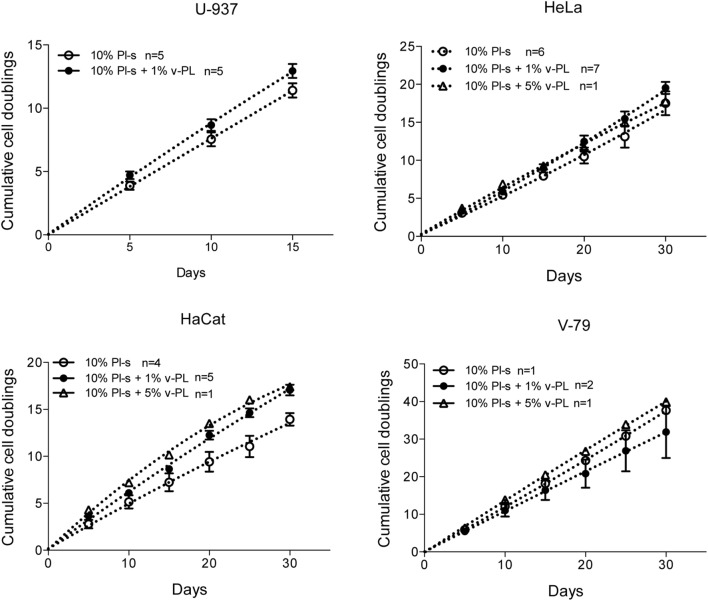
v-PL effect on cell proliferation—cell lines. The human cell lines U937, HeLa, HaCaT, and the hamster V79 cell line were cultured in the presence of different platelet- and plasma-derived supplements and their proliferation rate was monitored by calculating the number of doublings performed at different culture times. On the contrary to the behavior of the primary cell cultures, cell lines are less responsive to the v-PL mitogenic stimulus, and the culture condition in the presence of only serum is permissive to the proliferation of the cells both in adhesion or in suspension. Number (n) of cell cultures used for the experiments is indicated on the graph for each cell type.